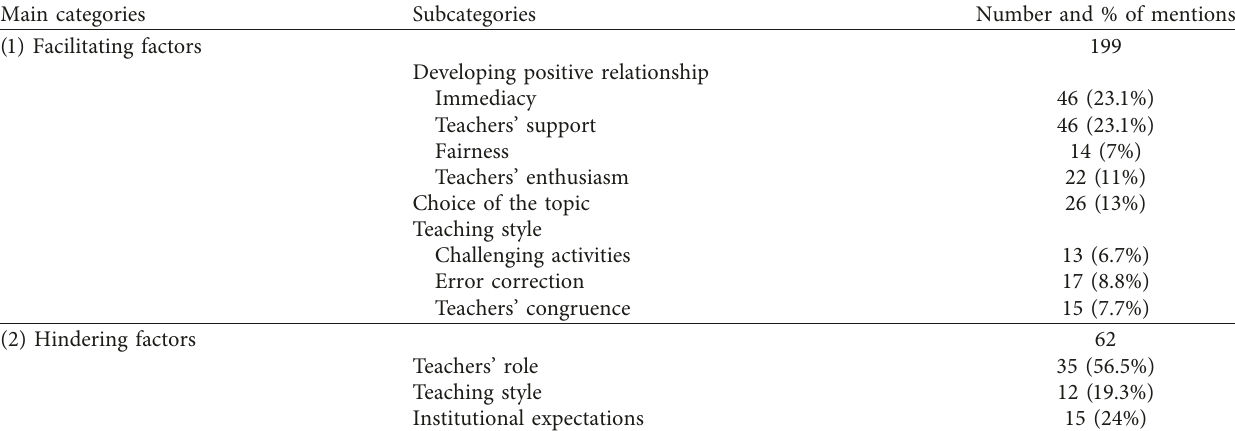
Table 3: Teachers’ perspectives on socioaffective and pedagogic strategies in raising